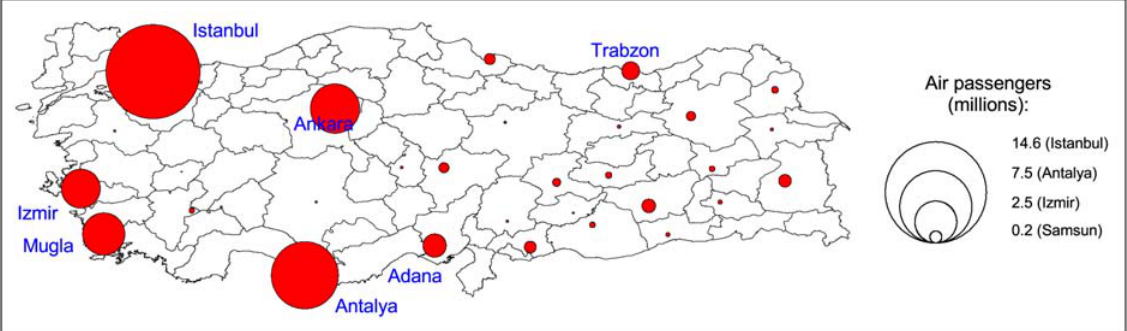
Figure 1. The distribution of total air passenger traffic among Turkish provinces for 2000